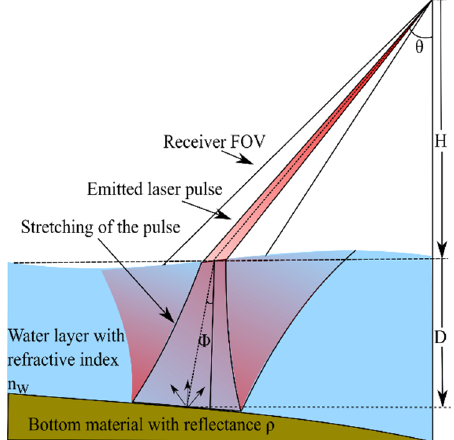
Figure 1. Illustration of the parameters used in the bathymetric LIDAR equation. Although the used LIDAR is not a bathymetric LIDAR the equation is used to show the dependencies present when the amount of water on top of a certain surface is high. These dependencies are used for the analysis of the street region when covered by water in Section 4.